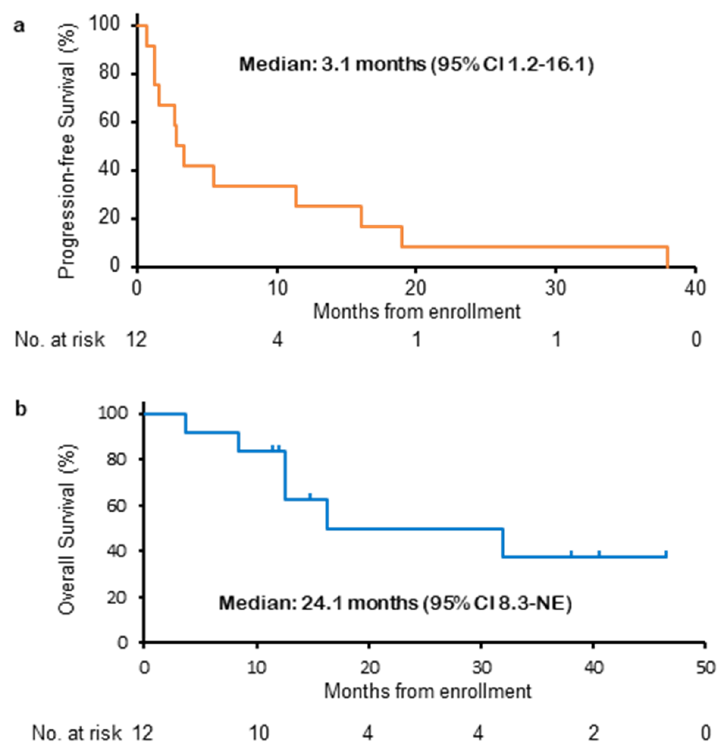
Figure 1. Kaplan–Meier curves for progression-free survival ( a ) and overall survival ( b ). NE; not evaluable.